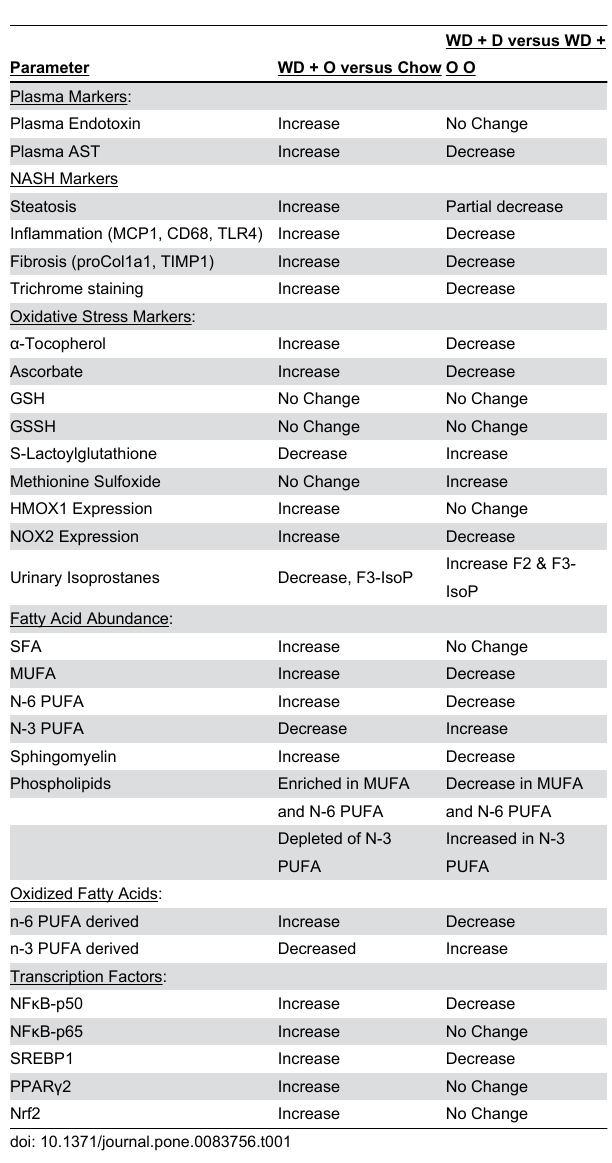
Table 1. Summary of diet effects on Ldlr -/- mice.